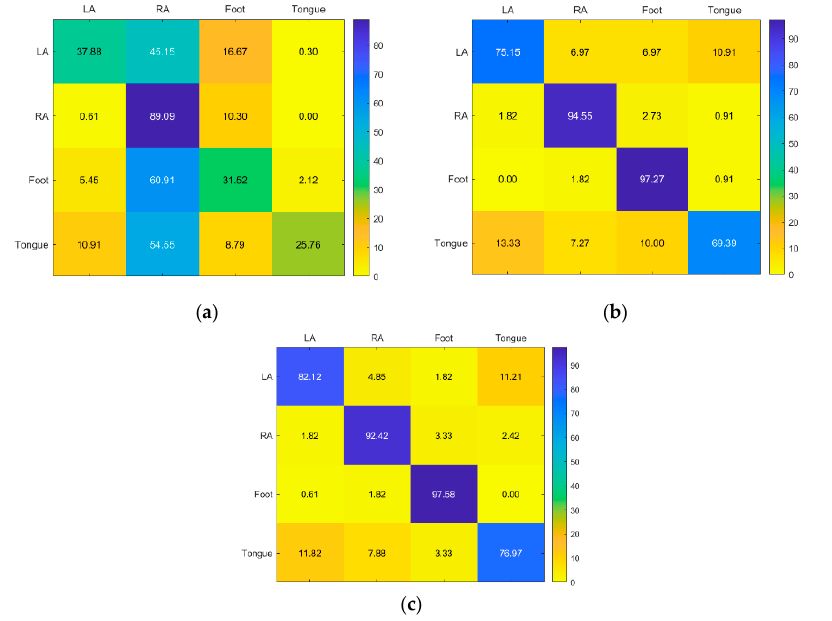
Figure 11. Confusion matrices for the ( a ) KNN, ( b ) SVM, and ( c ) RF classifiers to demonstrate the MI-BCI performance from the fifth subject’s four classes (left hand, right hand, feet, and tongue). The results for Subject 6 are good for RF and KNN, but poor for all classes for SVM. While KNN has good accuracy in LA, RF provided the greatest results for the RA, foot, and tongue (Figure 12).